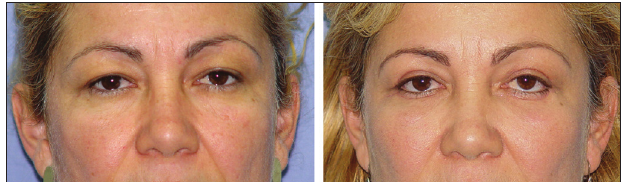
Figure 2. Patient with left lower eyelid malpositioning after blepharo- plasty caused by retraction.